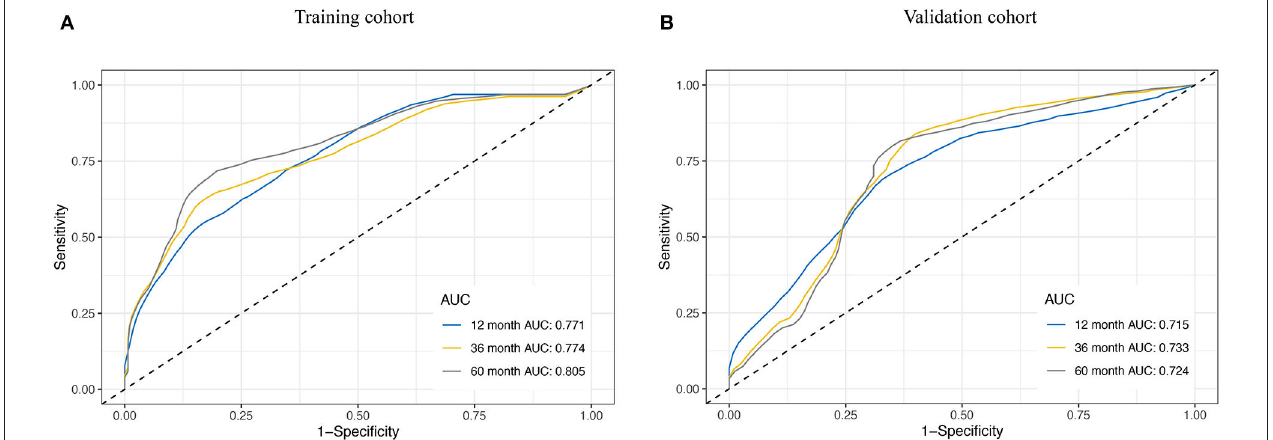
FIGURE 4 | Receiver operating characteristic (ROC) curve analysis for the survival prediction model. The time-dependent ROC curves for relapse-free survival (RFS) were plotted at 1, 3, and 5 years to evaluate the prognostic performance of the eight-RNA risk score model in the training cohort (A) and the validation cohort (B) .